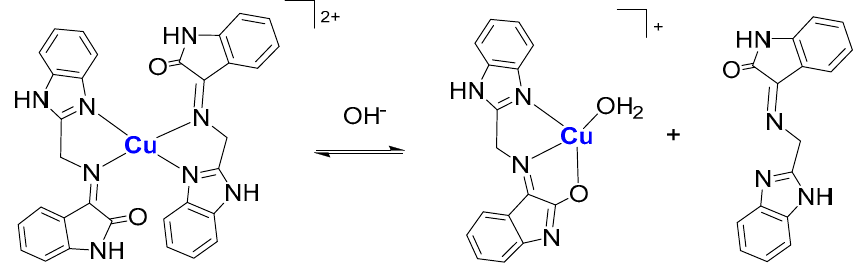
Figure 1. Scheme of the studied complexes, [Cu(isambz) 2 ] 2+ 1 , and [Zn(isambz)] 2+ 2 .